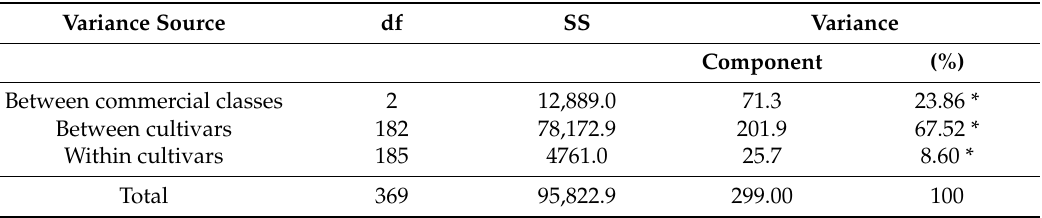
Table 2. Analysis of molecular variance (AMOVA) for the 185 Brazilian cultivars for two genetic levels: commercial classes and cultivars.